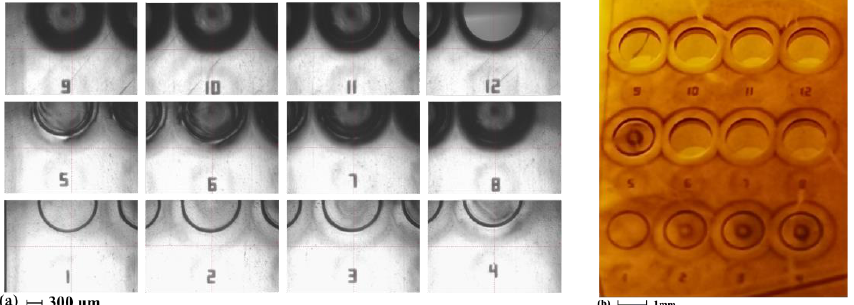
Figure 3. Calibration result for the laser micromachining process of polyimide. ( a ) After the laser micromachining; ( b ) After the copper etching.